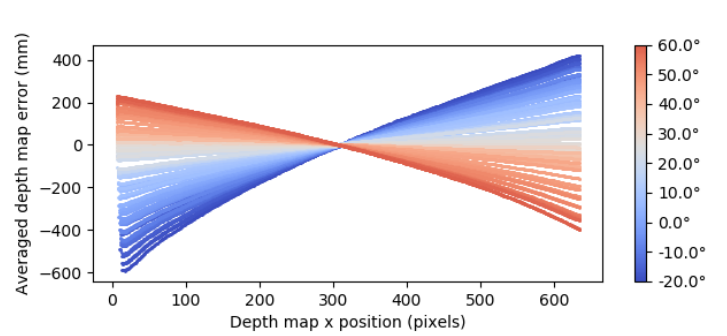
Figure 7. Measured depth error alongside X for different